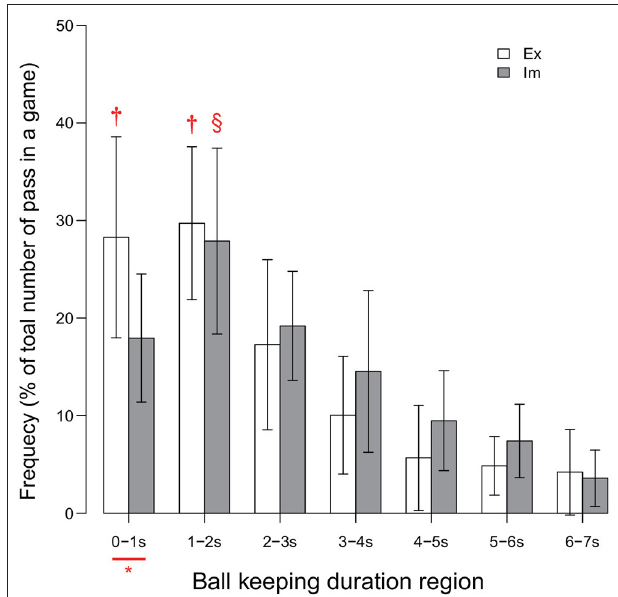
FIGURE 3 | Distribution of ball-keeping time. * indicates significant difference between the groups. Each of the two † in each of the two regions for the Ex group indicates a significantly higher frequency than those in all other regions for the Ex group. Symbol § for the Im group indicates that the data were significantly higher than those of all other region. Level of statistical significance was set to p <